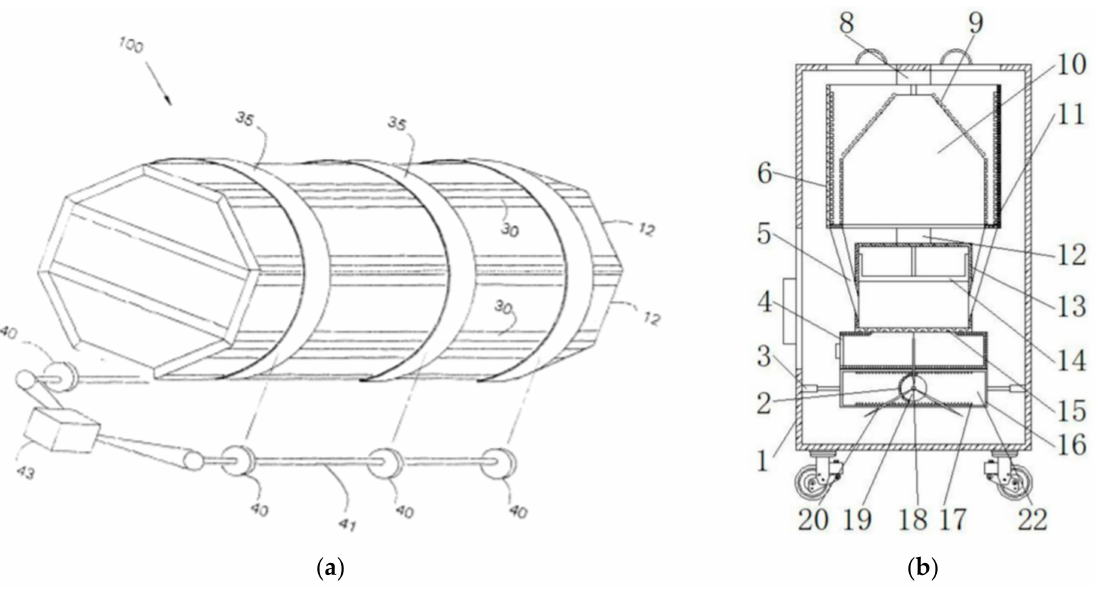
Figure 20. ( a ) An aerobic partially automated composter from CA2436322C [88], with details in Appendix A, Table A4; ( b ) an anaerobic partially automated composter CN112354616A [93], with details in Appendix A, Table